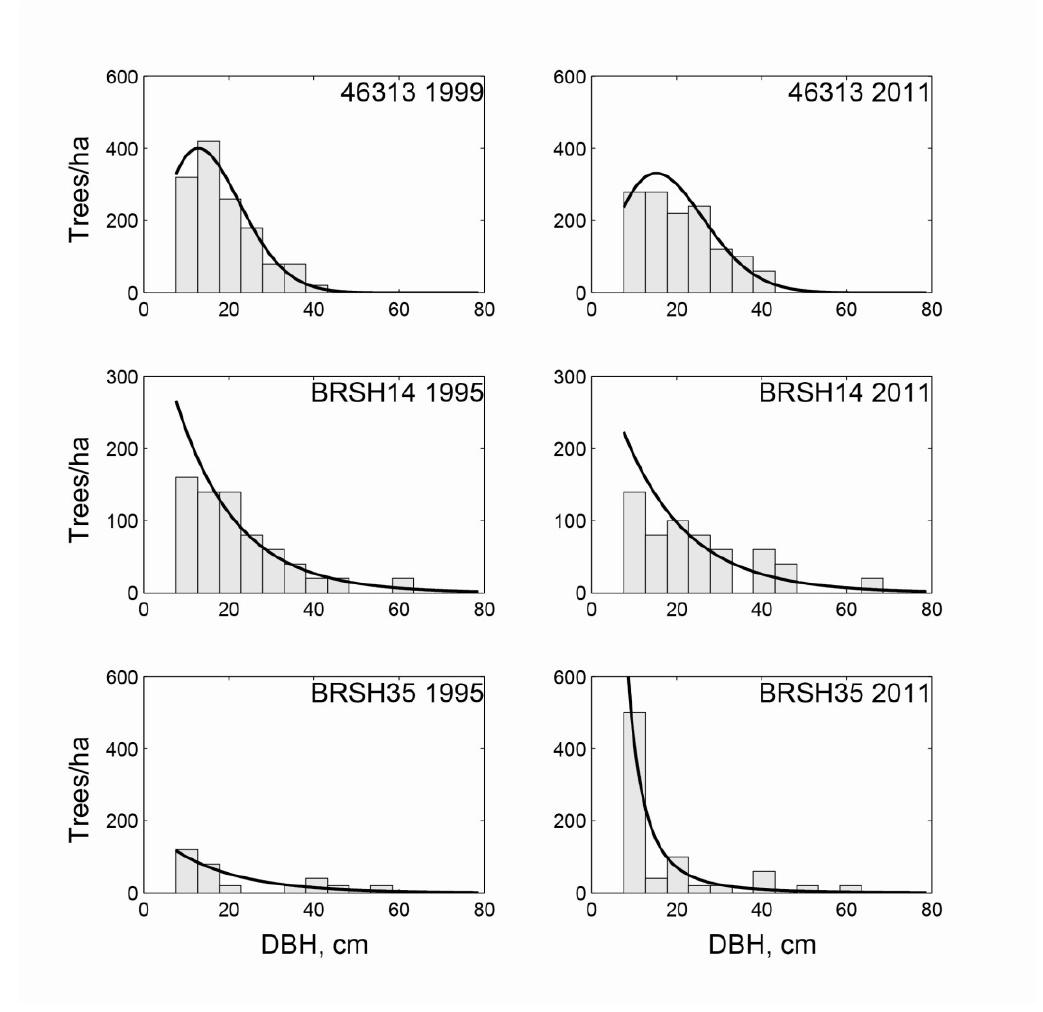
Figure 3. Examples of diameter distribution change in a late-successional plot (46313) and two old-growth plots (BRSH14 and BRSH35): Weibull remaining Weibull (46313), exponential remaining exponential (BRSH14), and exponential shifting to Weibull with shape parameter <1